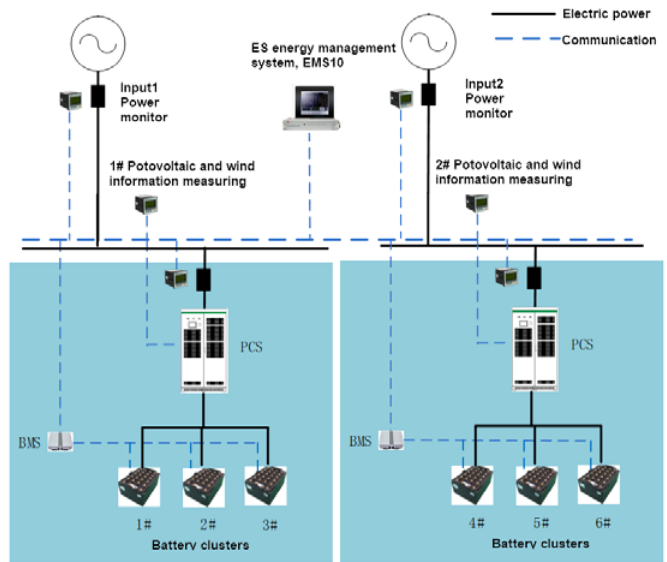
Fig. 5. Energy storage